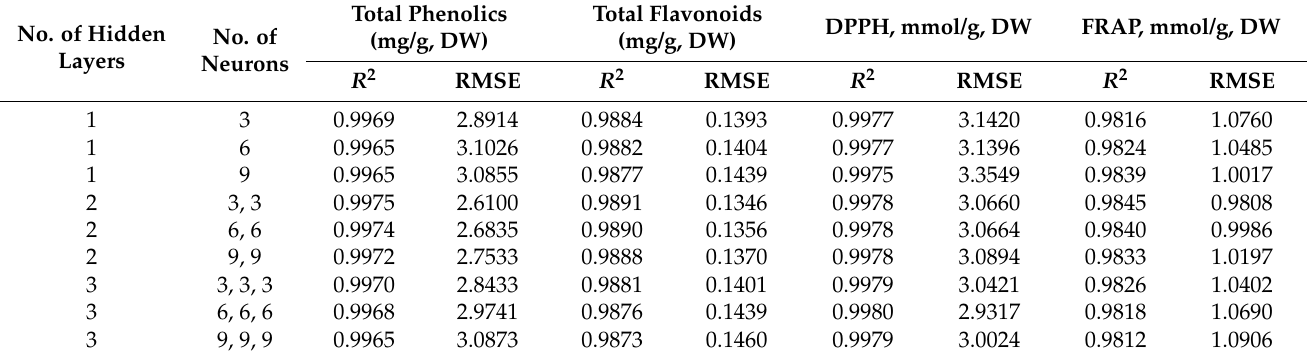
Table 7. Statistical results of chemical characteristics of linden leaf samples for ANN approach using